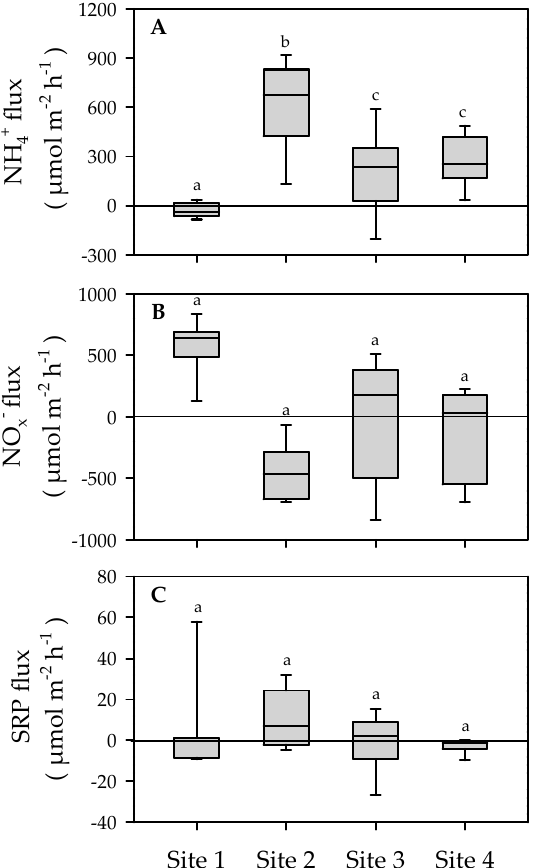
Figure 5. Sediment–water fluxes of ammonium ( A ), combined nitrite and nitrate ( B ), and soluble reactive phosphorus ( C ) measured at four study sites in the Sacca di Goro Lagoon (median and percentiles, n = 8). Different letters indicate statistical differences among sites.